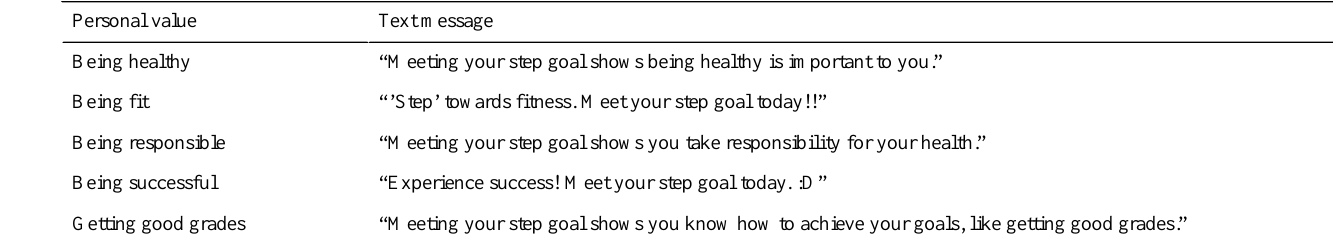
Table 1. Texts connecting personal values to meeting step goal.